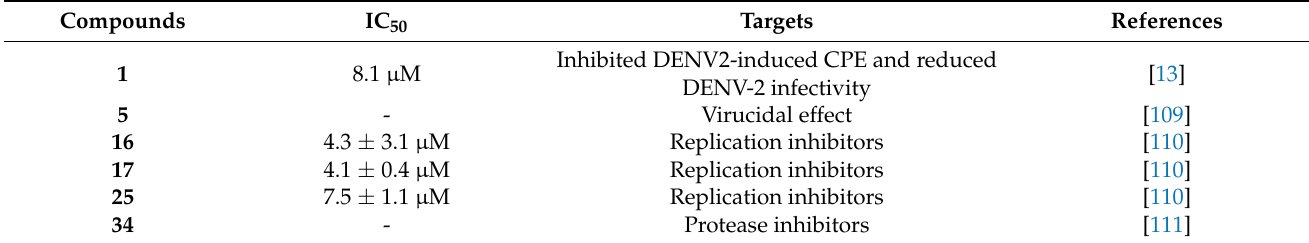
Table 9. Summary of anti-DENV triterpenoids and their targets and